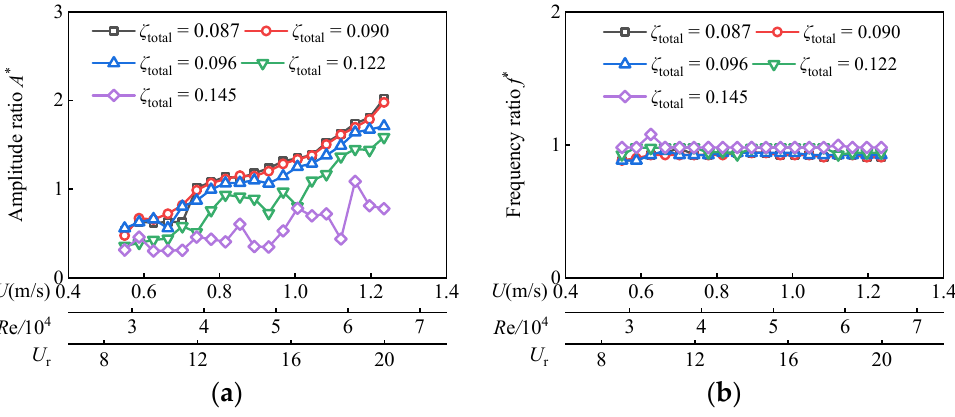
Figure 5. FIM of Cir-T-A tt with D = 0.06 m, Re = 2.89 × 10 4 ~ 6.51 × 10 4 . ( a ) Amplitude ratio. ( b ) Frequency ratio.